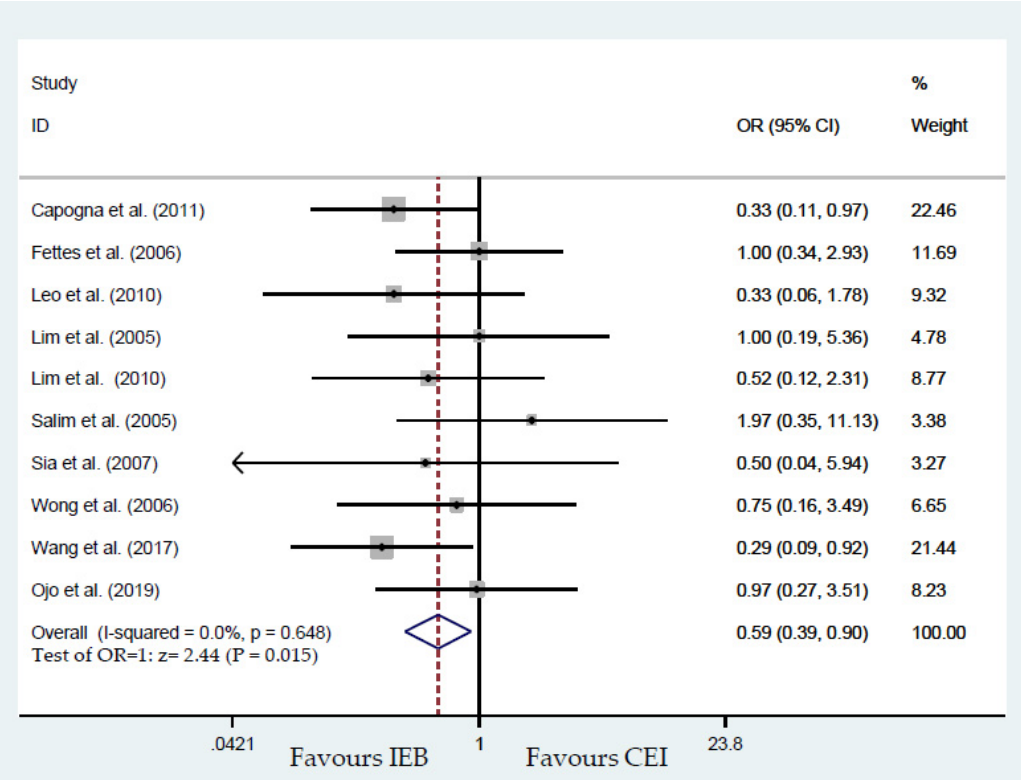
Figure 2. Overall e ff ect for cesarean delivery mode. Figure 2. Overall effect for cesarean delivery mode. Figure 2. Overall effect for cesarean delivery mode.